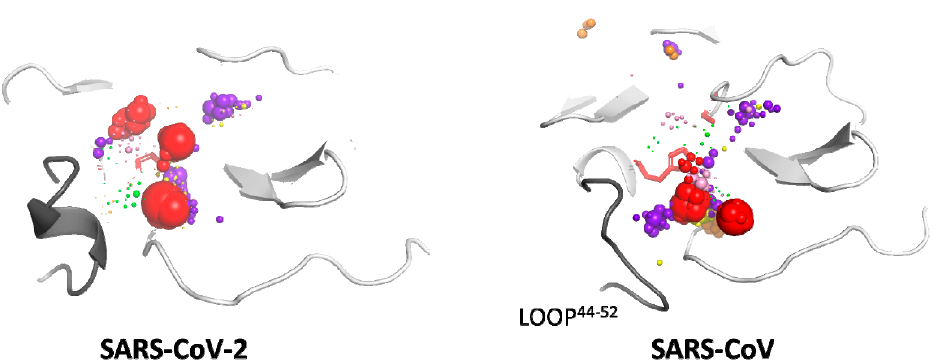
Figure 4. Localisation of the local hot-spots identified in the binding site cavities in SARS-CoV-2 and SARS-CoV main proteases. Hot-spots of individual cosolvents are represented by spheres, and their size reflects the hot-spot density. The colour coding is as follows: purple—urea, green—dimethylsulfoxide, yellow—methanol, orange—acetonitrile, pink—phenol, red—benzene. The active site residues are shown as red sticks, and the proteins’ structures are shown in cartoon representation; loop 44–52 is grey. The proteins’ structures come from the MD simulation snapshots (first frame of the production stage).